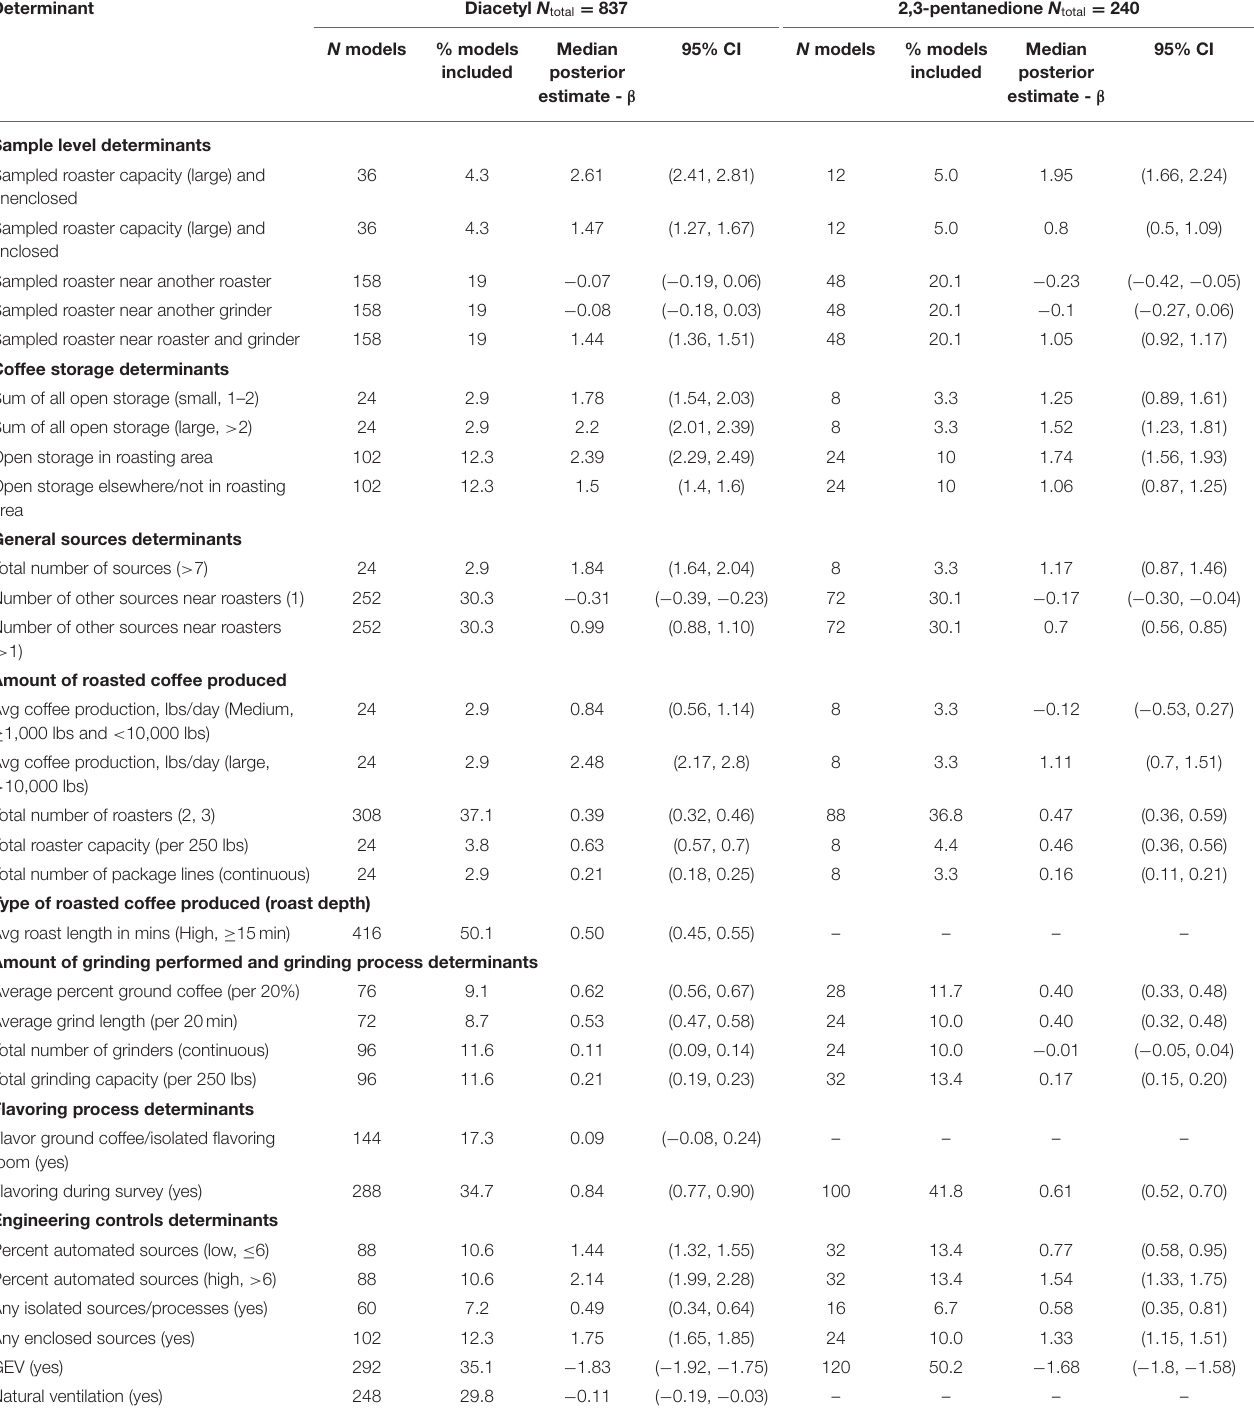
TABLE 3 | Bayesian model averaging results for diacetyl and 2,3-pentanedione exposures during roasting tasks. Determinant Diacetyl N total = 837